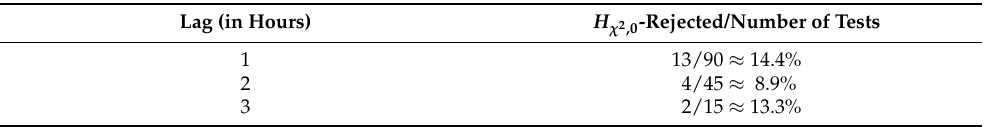
Table 14. Lags and H χ 2 ,0 rejection ratios for which the domains of W t and T t were split into the numbers of intervals satisfying the recommendations REC 1 and REC 2 .